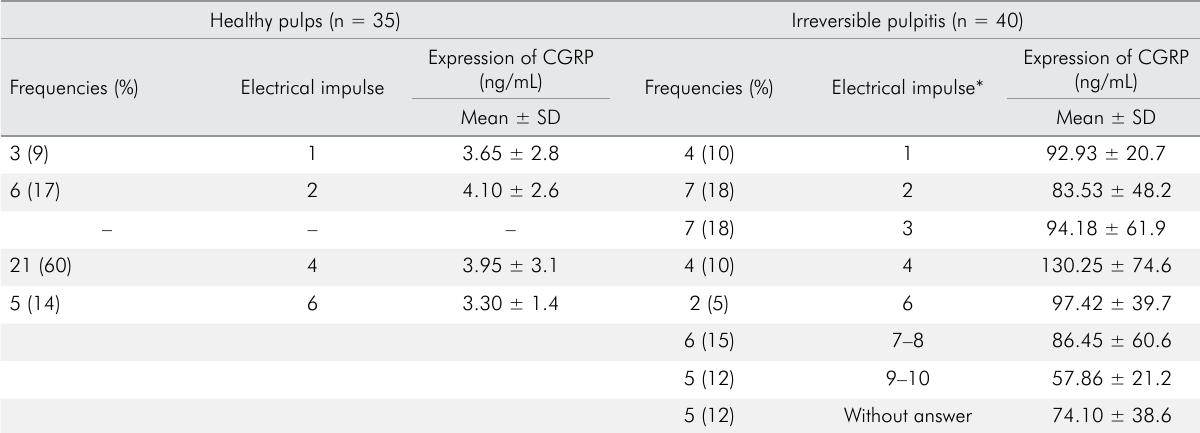
Table 4. Expression of CGRP and response to an electrical impulse (electric test) in healthy pulps and in irreversible pulpitis. Healthy pulps (n =